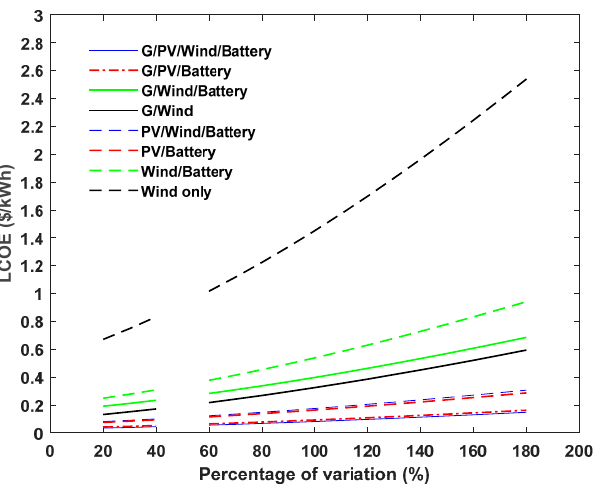
Figure 11. Influence of the variation in the battery cost on the LCOE of the studied systems.